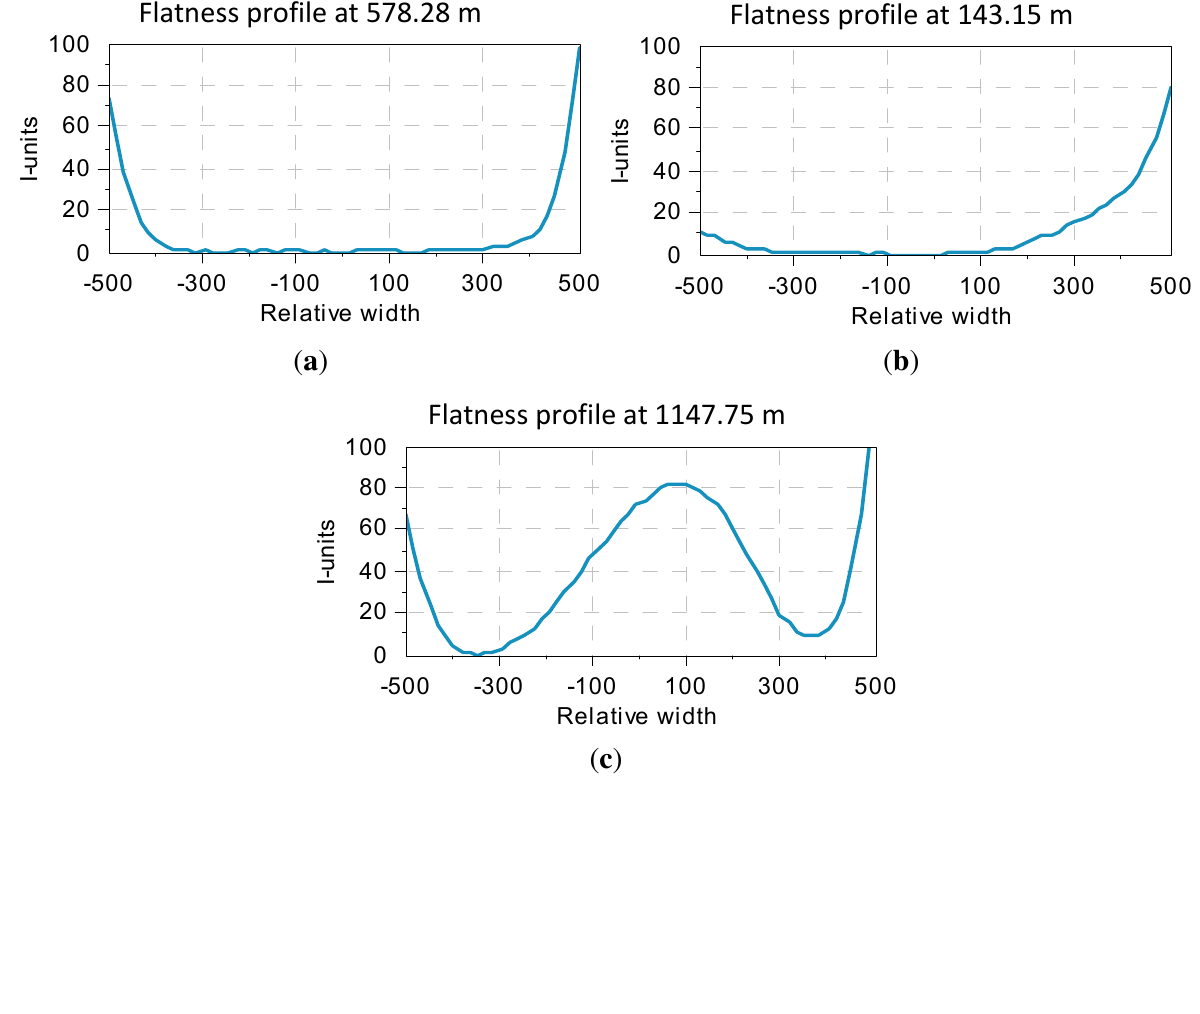
product: ( a ) flatness profile showing wavy edges defect; ( b ) flatness profile showing bad leveling; ( c ) flatness profile showing center buckle and wavy edges. These flatness measurements have been taken by the flatness sensor described in